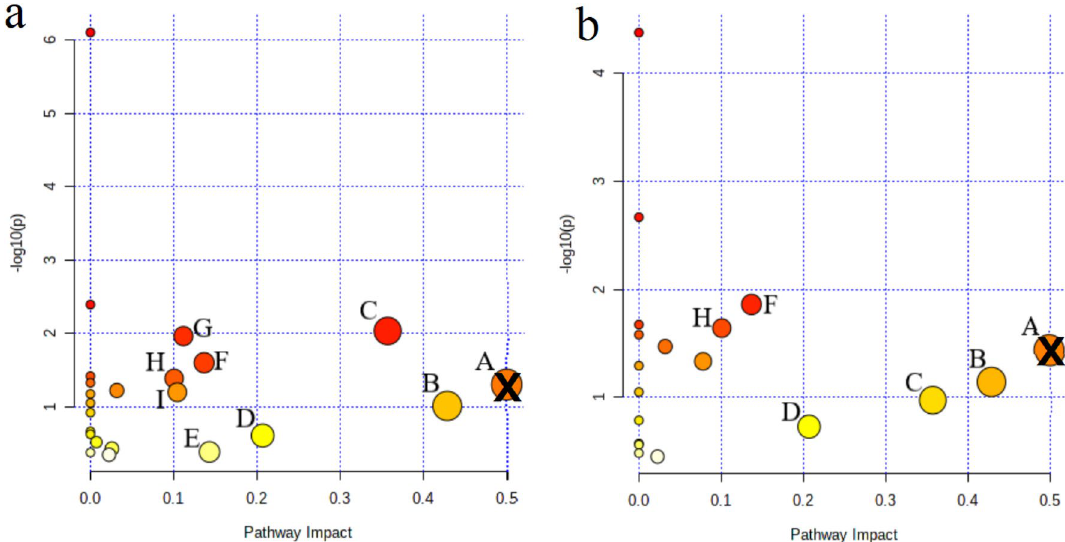
Figure 4. Summary diagram of pathway analysis with Met-PA. ( a ) The metabolic pathways associated with depression; ( b ) Regulation of metabolic pathway of aerobic exercise. A: phenylalanine, tyrosine and tryptophan biosynthesis ( ×); B: taurine and hypotaurine metabolism; C: phenylalanine metabolism; D: pyruvate metabolism; E: tryptophan metabolism; F: citrate cycle (TCA cycle); G: arginine and proline metabolism; H: glycolysis/gluconeogenesis; I: cysteine and methionine metabolism. Each circle represents one metabolic pathway; the size of the circle and shades of color are positively correlated with the impact on the metabolic